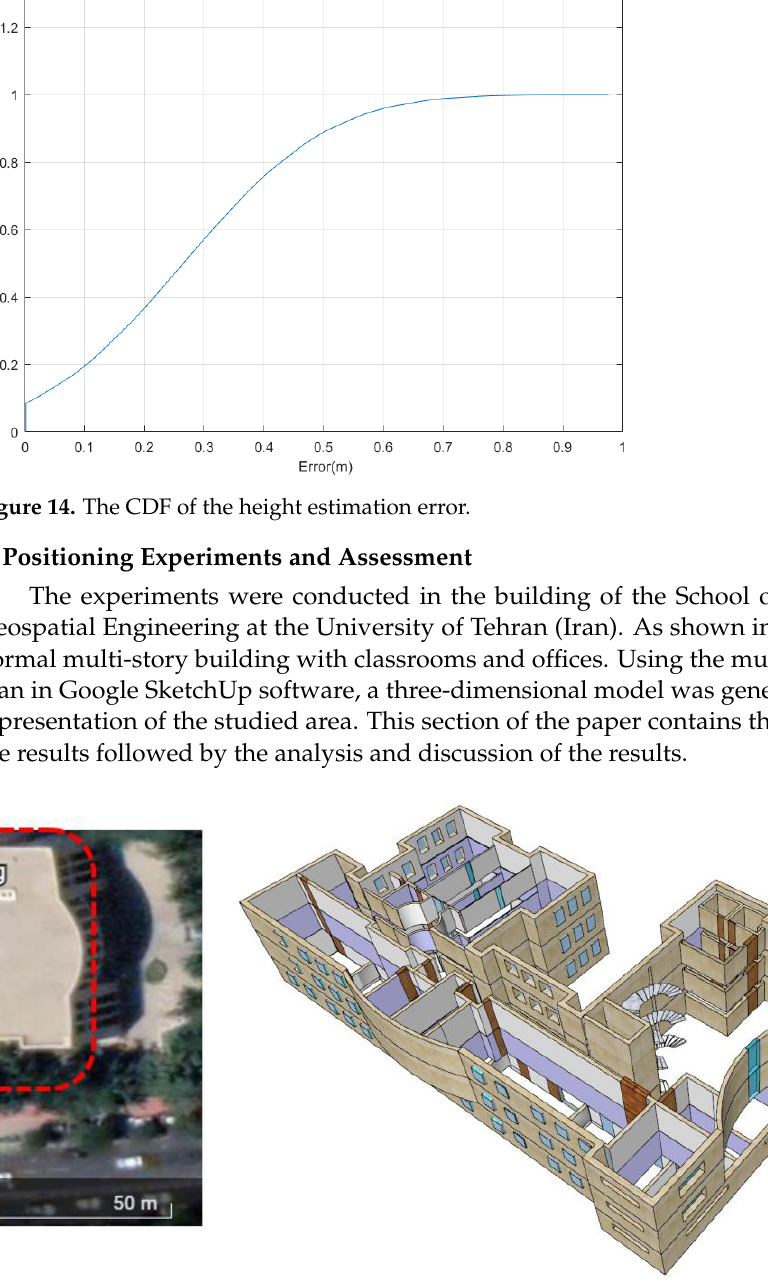
( b ) Figure 13. ( a ) The sensor ’ s measurements; ( b ) altitude values derived from pressure sensor meas- urements. The values of altitude estimation error were calculated based on differences between